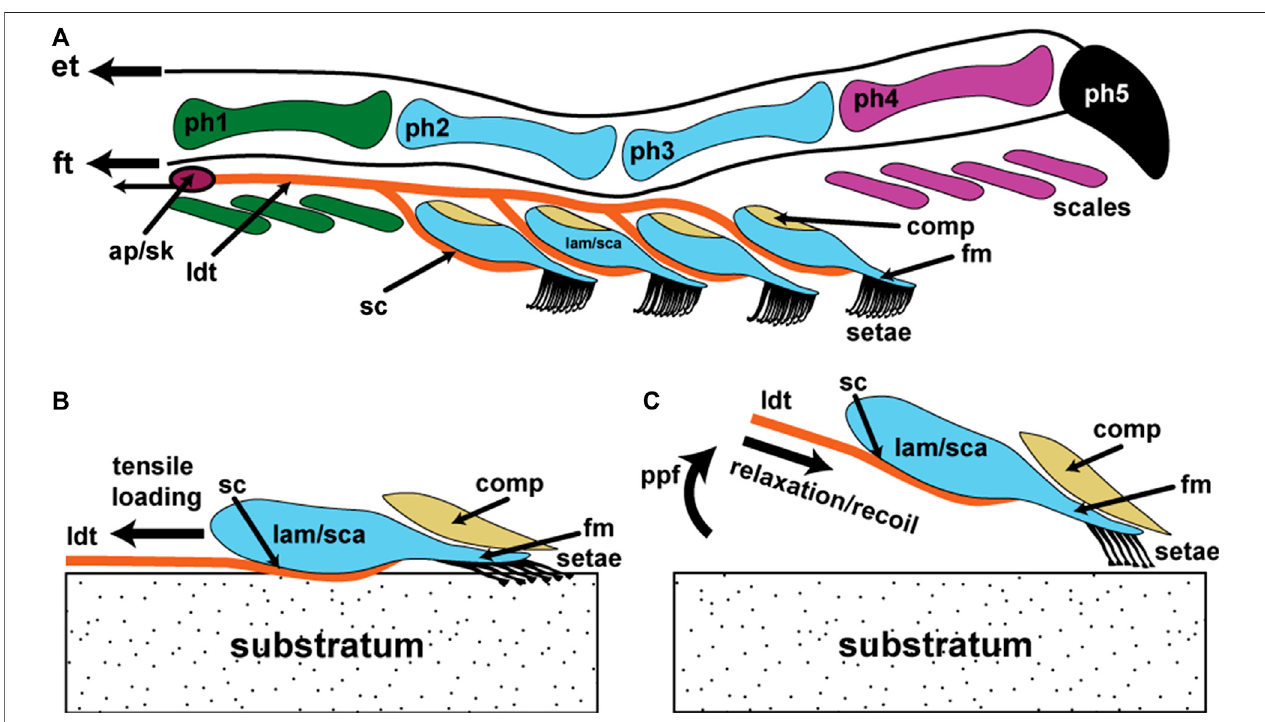
FIGURE 9 | Schematic representation of the basic components of the lacertilian digital adhesive system assembled as a model for the operation of this basic mechanism.Informationaboutstructureisderivedfromacombinationofanolesandgekkotantaxaexhibitingincipienttoepads. (A) DiagrammaticlateralviewofdigitIV. Phalanges1 – 5(ph1 – ph5)andtheirassociatedventralscales(colorcodedtomatchthephalanges)thatbearmicro-ornamentationthatismodi fi edintounbranchedsetae bearing a single spatulate tip on the free margin of enlarged scales (lamellae/scansors; lam/sca) situated beneath phalanges 2 and 3. The rows of setae on each lamella/scansorincreaseinlengthfromdistaltoproximal.Eachlamella/scansorhasanexpandedproximalzonewithanextensivedermalandsubdermalcore.Itsventral integument consists of epidermis and a dermal stratum compactum (sc) dominated by linearly-arranged (parallel with the long axis of the digit) collagen fi bers that is continuouswiththelateraldigitaltendons(ldt)lyingtoeithersideofthephalanges.Thissc/ldtcontinuumislinkedtoanaponeuroticnetwork(ap)controlledbymusclesin the fl exor compartment of the lower limb and anchored onto skeletal elements (sk) that limit the tensile loading placed upon it. Overlying the setal batteries is a fl exible compliance system (comp) that, when pressurized during application of the lamellae/scansors to the substratum, assists in aligning the setal batteries into a continuous setal fi eldalongthelengthofthetoepad.Extensor(et)and fl exor(ft) tendons,throughtheactionsoftheirassociatedmuscles,controltheclawand fl exionand extension of the entire digit. Lamellae/scansors also possess a thin, fl exible free margin (fm). (B) Diagrammatic lateral view of a single lamella/scansor with the setae applied to the substratum in the adhesion mode. (C) Diagrammatic lateral view of a single lamella/scansor in the process of being released from adhesive contact with the substratum as a result of digital hyperextension, driven by pedal plantar fl exion (ppf).